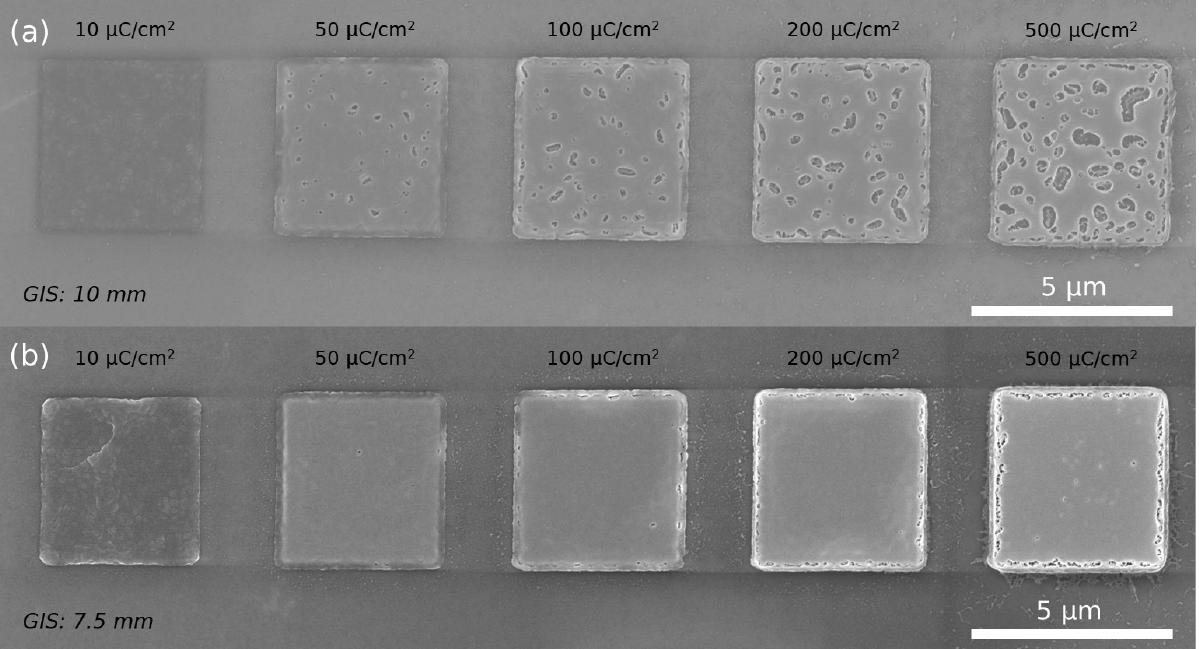
Figure 2. W–C squares deposited with variable ion doses at a distance from the GIS of ( a ) 10 mm, and ( b ) 7.5 mm. The deposition times are, for each square, and in order of increasing dose, 0.2, 1.0, 2.1, 4.2, and 10.3